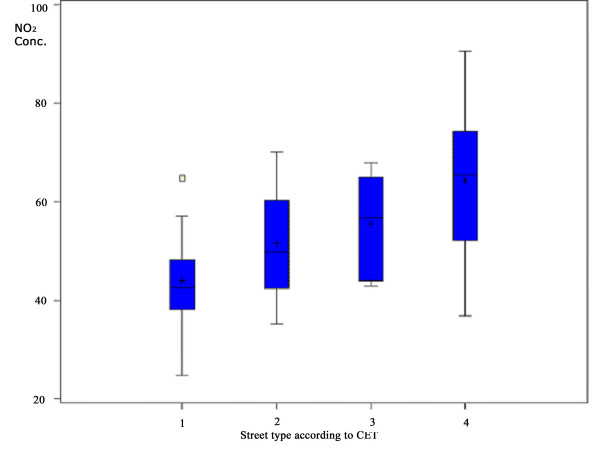
NO2 concentration according to the CET street classification. 1 = LOC – Streets only with local traffic, low traffic density. 2 = COL – Local and intermediate traffic, predominance of local traffic and median flow of vehicles. 3 = ART – Local and intermediate traffic, and median to high flow of vehicles. 4 = VTR – Avenues that collect all traffic and give access to different destinations and have high traffic density.